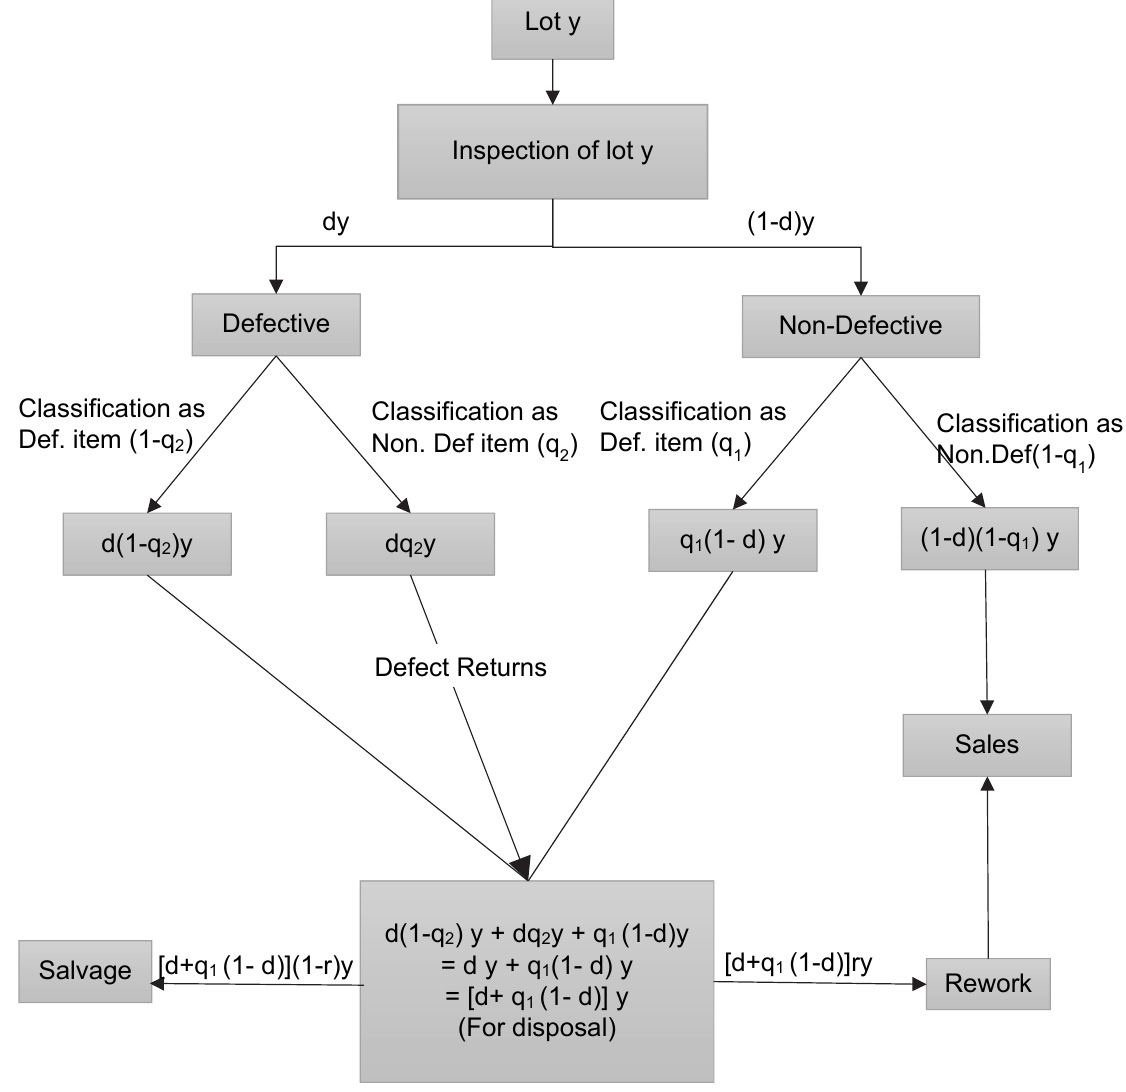
Fig. 1. Flowchart of the processes taking